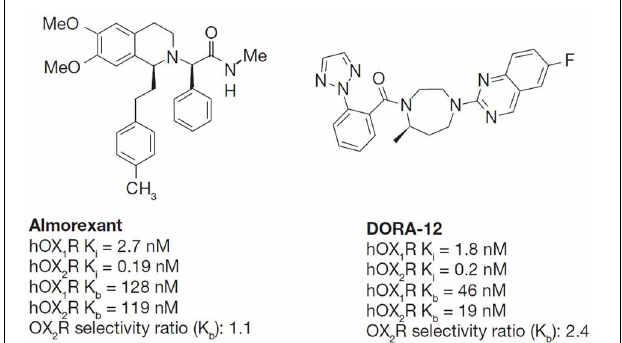
FIGURE 1 | The chemical structures of almorexant and DORA-12. Both almorexant and DORA-12 have similar antagonistic activity on both orexin receptors with slight OX 2 R selectivity in affinity. K i , competitive inhibition binding constant determined in ligand displacement assays of Chinese hamster ovary (CHO) cell membranes expressing recombinant human OX 1 R and OX 2 R, K b , functional inhibition of OX-A[Ala6,12]-induced calcium mobilization in CHO cells expressing human OX 1 R and OX 2 R in fluorimetric imaging plate reader (FLIPR) assays. The in vitro potency of DORAs, including almorexant, for OX 1 R and OX 2 R is consistent across species and less than 2-fold differences are observed between human and rat receptors (Winrow et al.,